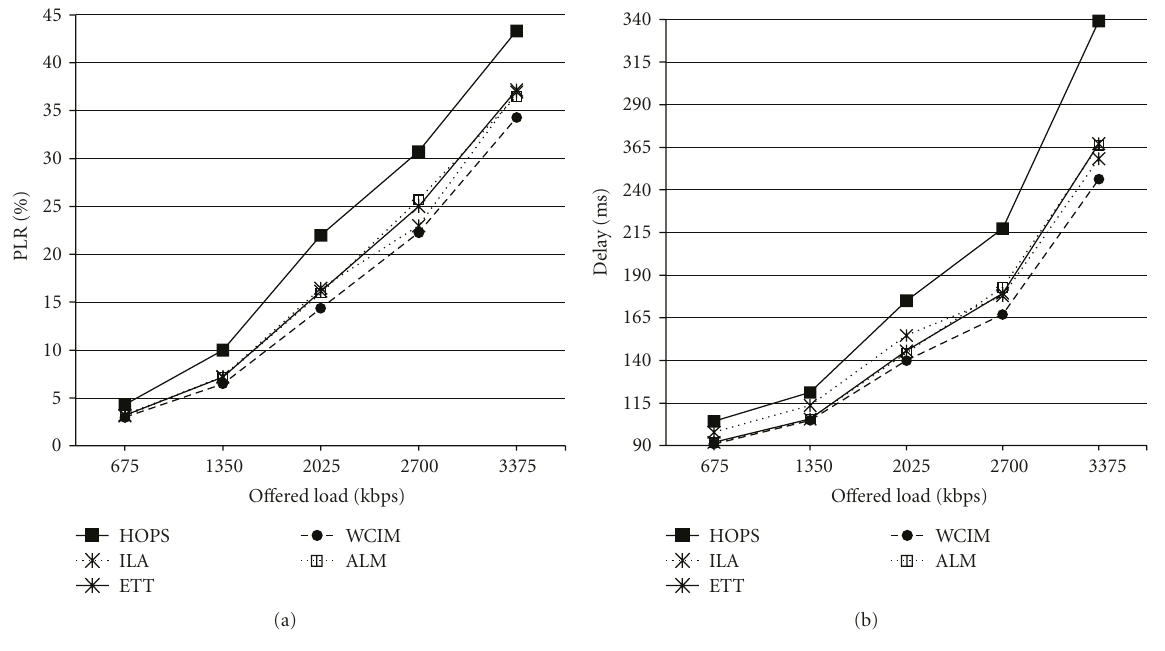
Figure 9: Scenario 4 results. (a) Packet loss rate. (b) End-to-end